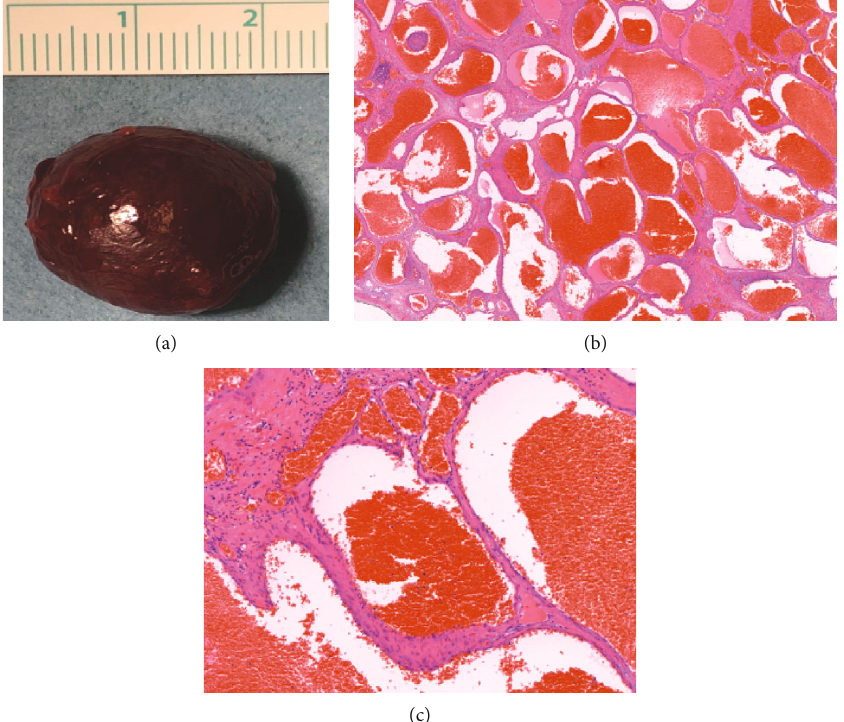
Figure 3: (a) Gross appearance of the excised orbital tumor showing the reddish well-circumscribed mass. (b) Histopathological examination reveals enlarged vascular channels with thick walls, the lumens of which were fi lled with erythrocytes, consistent with orbital cavernous hemangioma ( H : E : × 20 ). (c) Higher magni fi cation view of vascular structures lined by endothelium and fi lled with erythrocytes ( H : E : × 100 ).